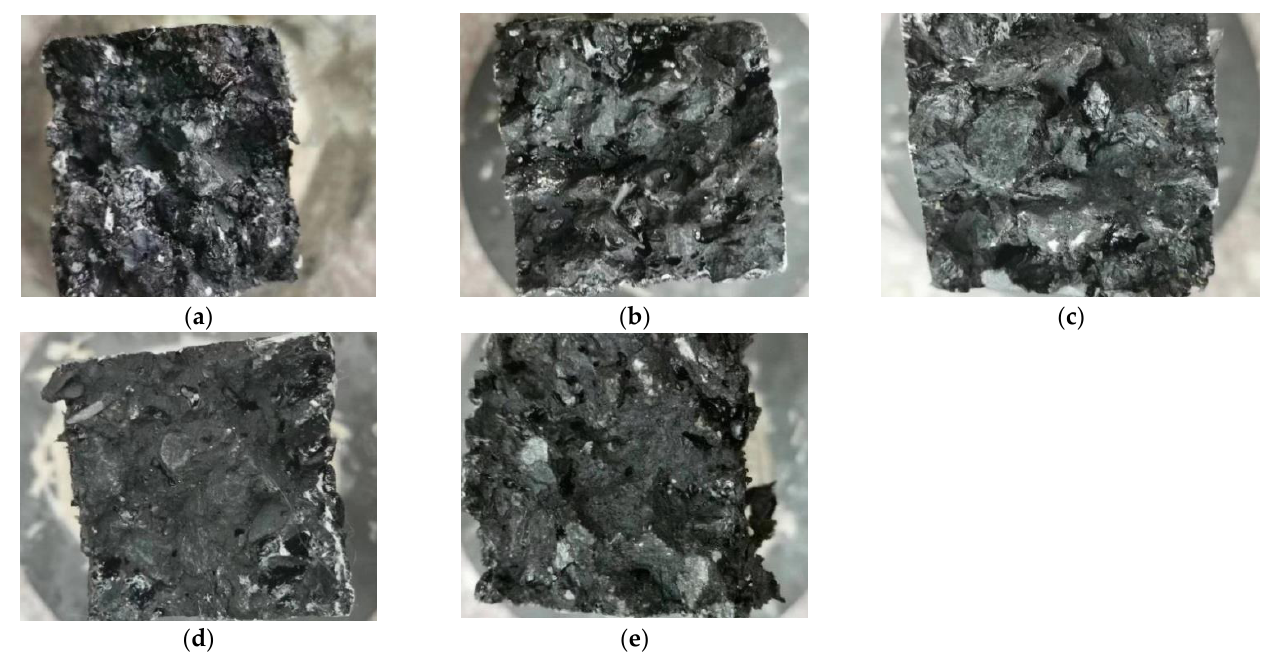
Figure 4. Fracture surface morphology of GFSMA specimens: ( a ) 0.3 wt%; ( b ) 0.4 wt%; ( c ) 0.45 wt%; ( d ) 0.50 wt%; ( e ) 0.55 wt%.